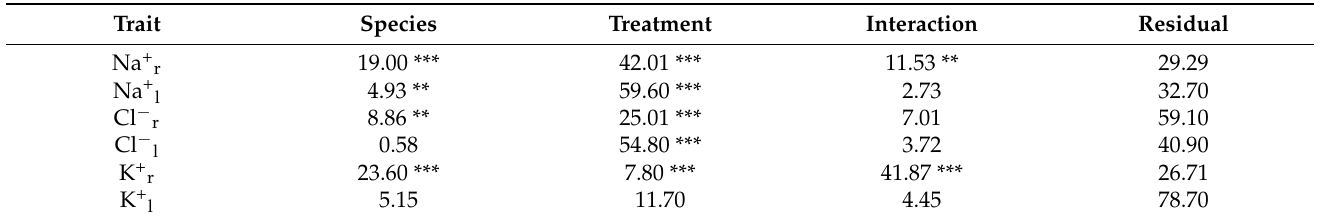
Table 3. Two-way analysis of variance (ANOVA) of species, treatment, and their interactions for the monovalent ions